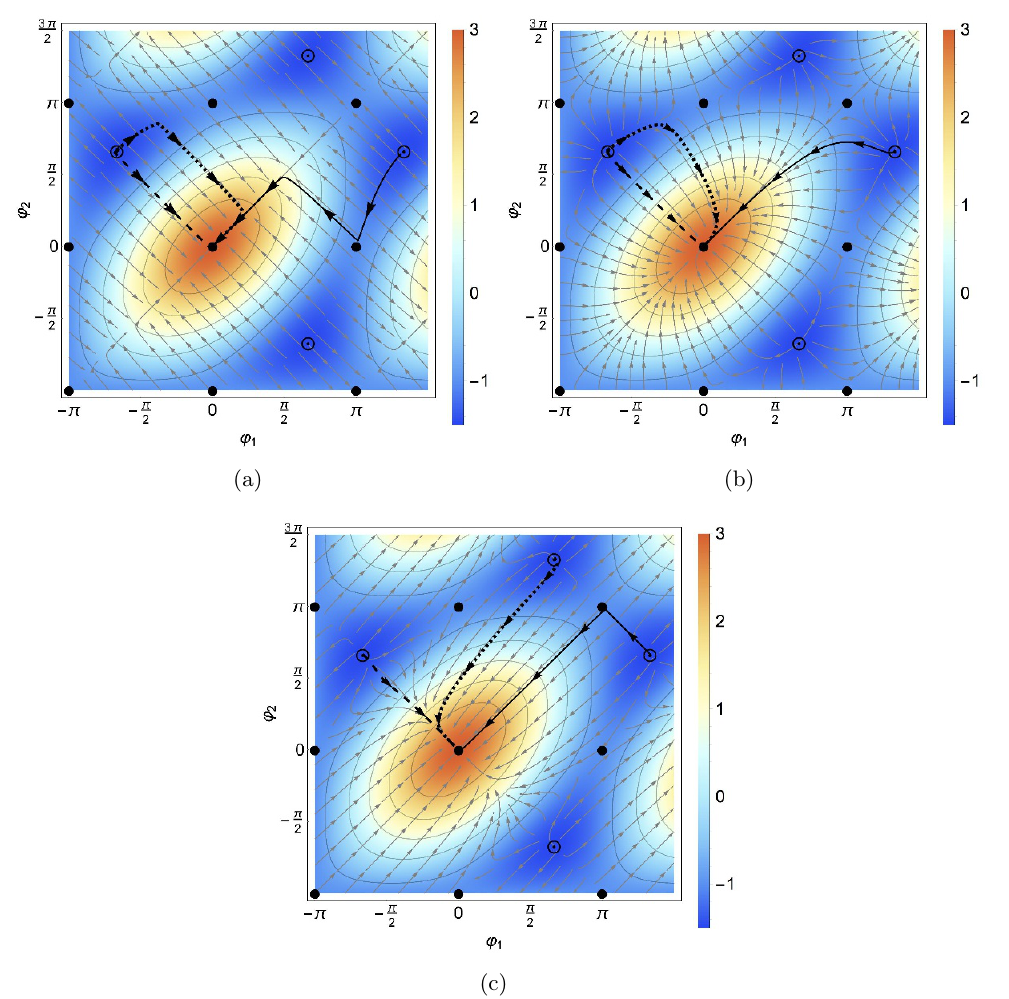
Figure 4 . The pre-potential U( ’ 1 ; ’ 2 ) for the case of SU(3) in which (cid:13) 1 = (cid:13) 2 = (cid:13) 3 = 1 and the coupling parameter (cid:21) takes values (a) (cid:21) = (cid:0) 1 : 8, (b) (cid:21) = 0 and (c) (cid:21) = 1 : 8. These three examples of the numerical BPS solutions correspond to the curves that connect extrema of the